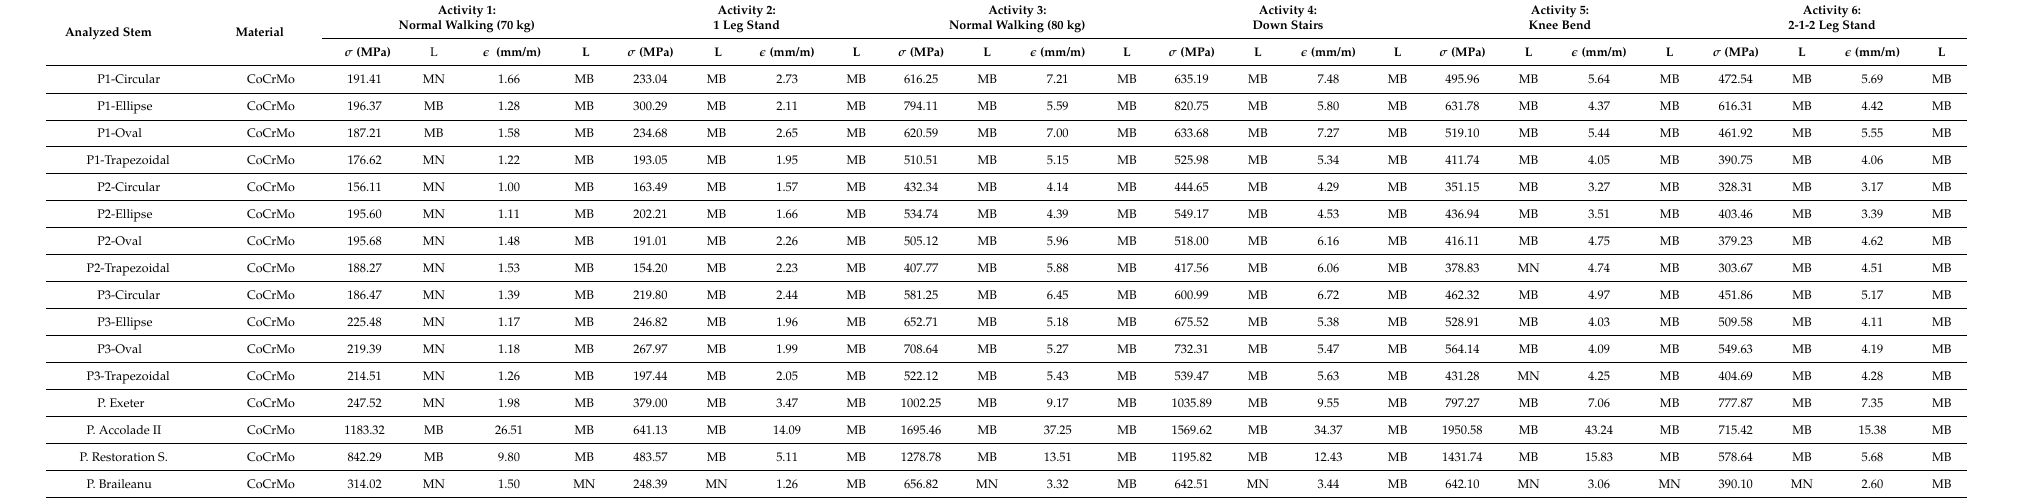
Table A1. Stems maximum stress ( σ ) and equivalent strain ( (cid:101) ), for six different activities and its respective location indicated by MN = Medial Neck, MB = Medial Base.